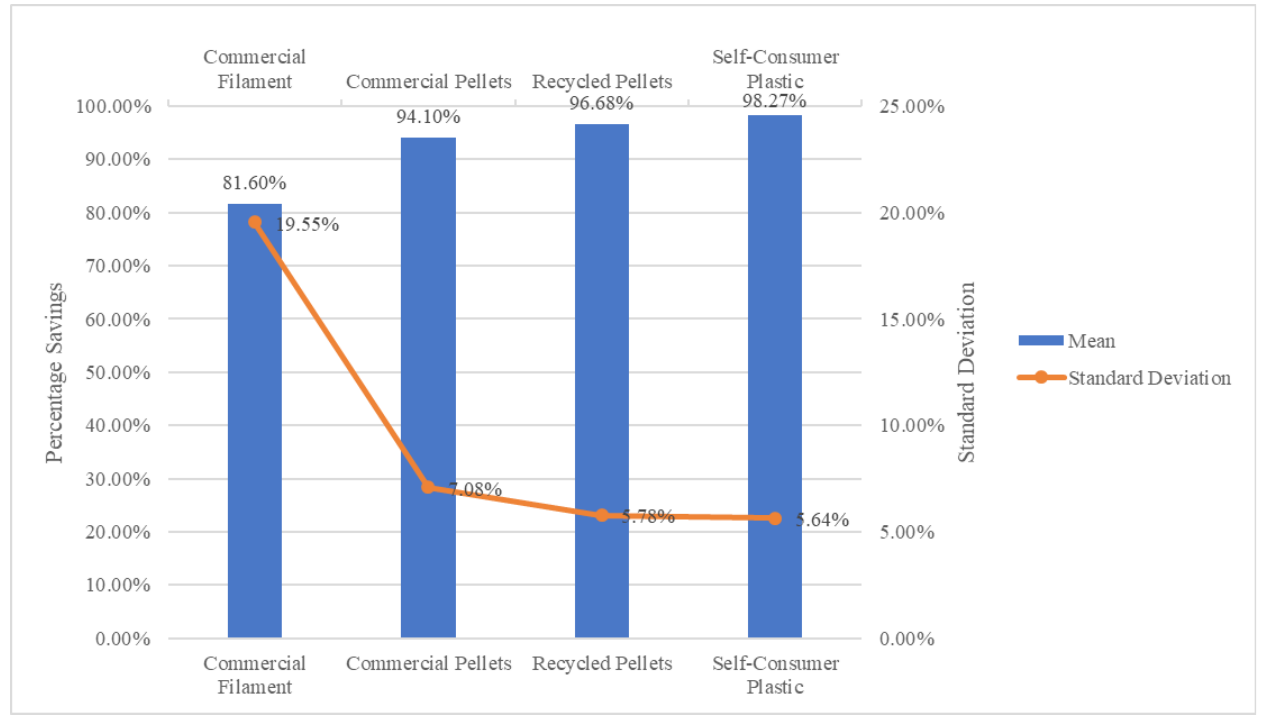
Figure 9: The mean of percentage savings for four types of AM materials